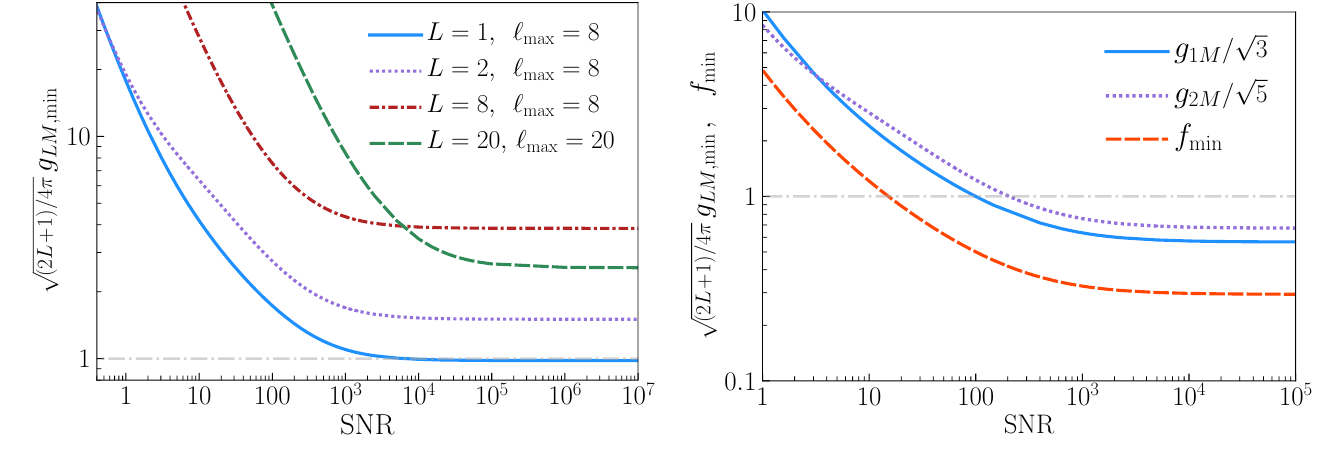
FIG. 3. For (cid:96) max = 8, the smallest detectable dipole- anisotropy amplitude d (which is 3 − 1 / 2 times the g 1 M, min plotted in Fig. 1), and the smallest detectable quadrupole- anisotropy amplitude, shown together with the smallest de- tectable (again, at 3 σ ) beam amplitude f obtained with mea- surements of g L 0 up to L=8 is f min (cid:39) 0 . 28 in the high SNR